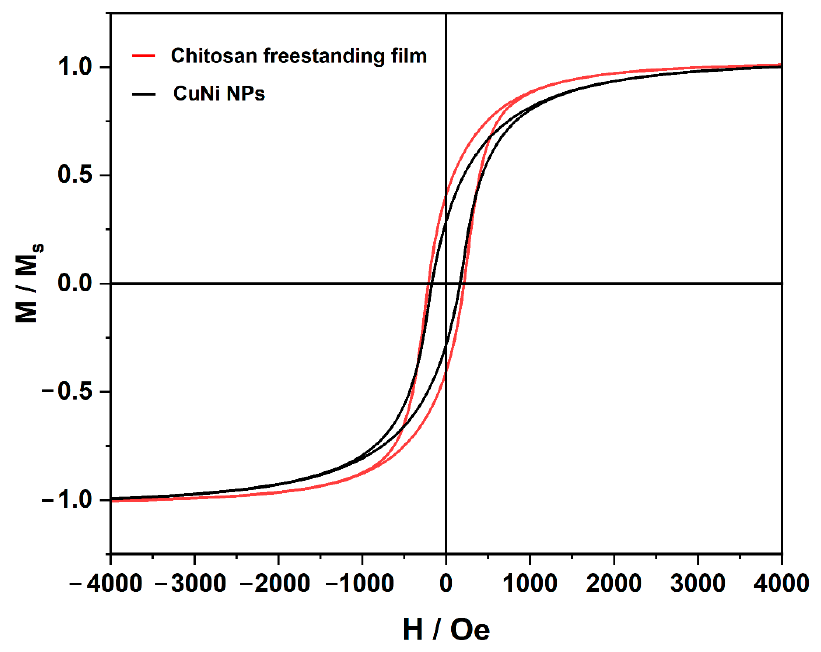
Figure 8. Room-temperature hysteresis loops of CuNi NPs and chitosan freestanding film.